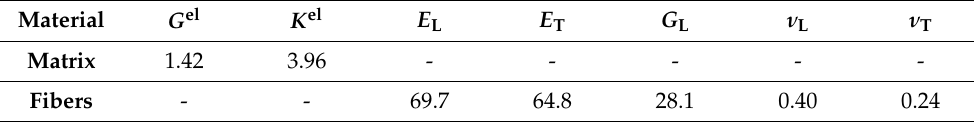
Table 4. Phase elastic properties. Elastic moduli are in